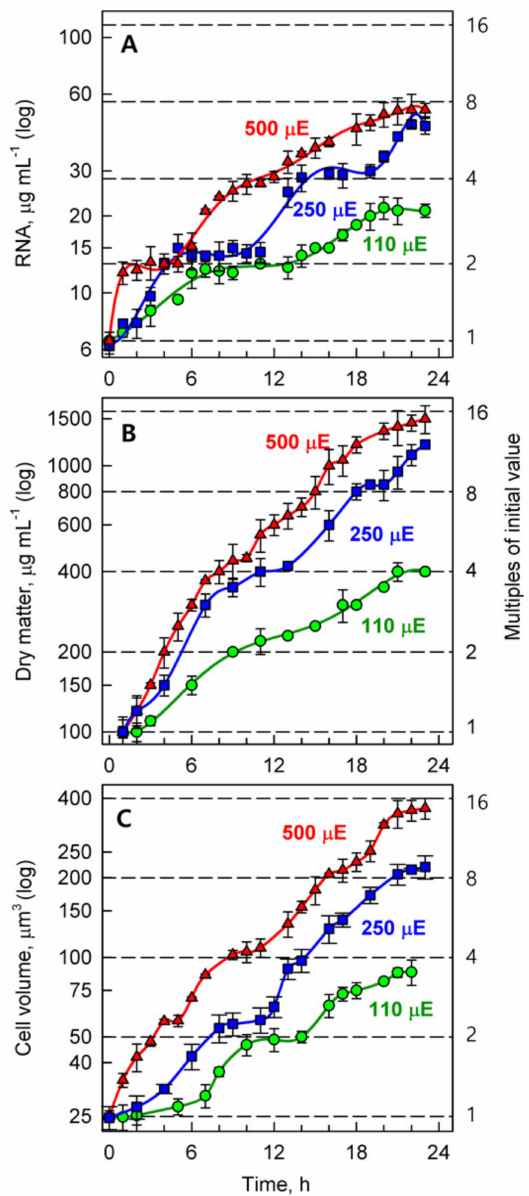
Figure 6. Time course of growth events in the synchronized cultures of Parachlorella kessleri grown at the optimal temperature of 30 ◦ C and different incident light intensities (500 (red triangles), 250 (blue squares), 110 (green circles) µ mol photons m − 2 s − 1 ). Panel ( A ): RNA ( µ g mL − 1 ), Panel ( B ): Dry matter ( µ g mL − 1 ), Panel ( C ) Cell volume ( µ m 3 ). Note the logarithmic scale on the Y axis. Horizontal dashed lines indicate doublings of the initial